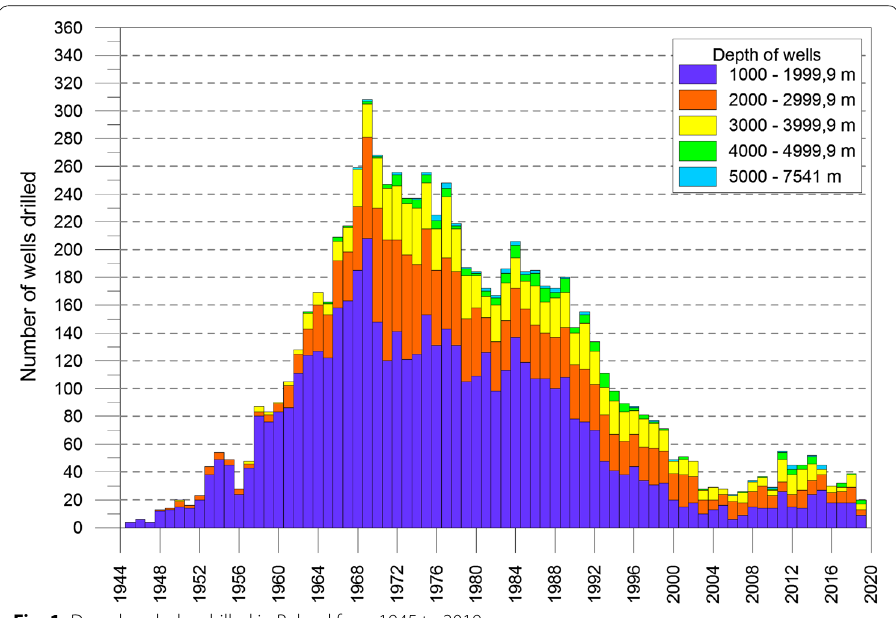
Fig. 1 Deep boreholes drilled in Poland from 1945 to